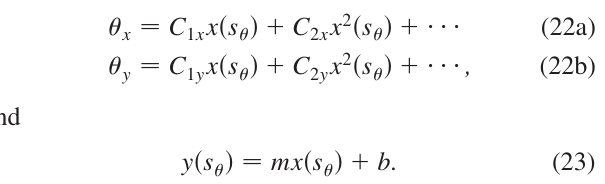
FIG. 2. Horizontal magnetic kick error (cid:1) as functions of the horizontal particle position netic kick error (cid:1) y Þ . The typical dependence between the horizontal particle x ð s (cid:1) Þ and the vertical particle position y ð s position x ð s (cid:1) shown. Eight simulated first turn trajectories with different amplitudes have been used to obtain this